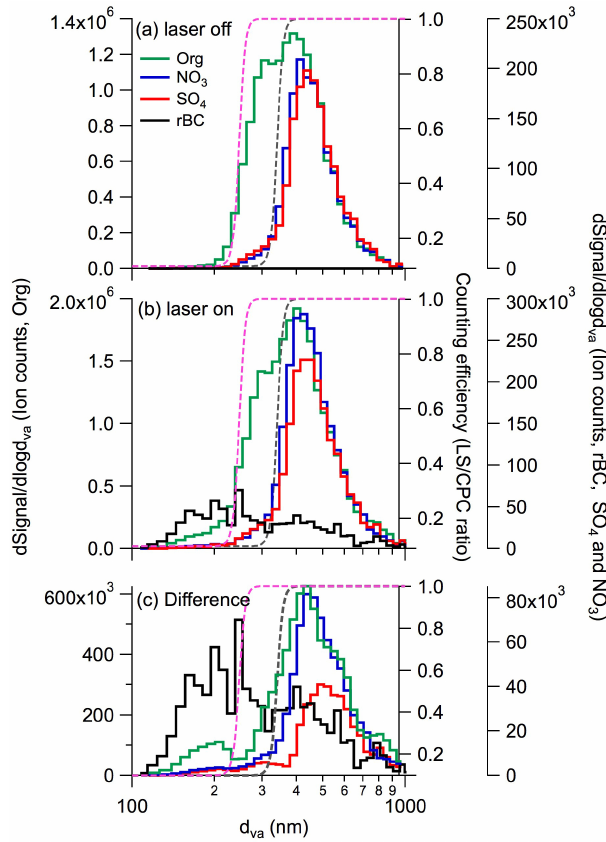
Figure 7. Integrated size distributions of nitrate, sulfate, organics and rBC from the single particle ion signal measurements with IR laser-off (a) and on (b) . (c) Differences between laser-on and off modes (i.e., laser-on minus laser-off data). The grey dashed line represents the counting efficiency (LS/CPC) of the light scattering module for ammonium nitrate particles. The pink dashed line indi- cates an estimated light scattering cutoff d va for spherical hydrocar- bon oil